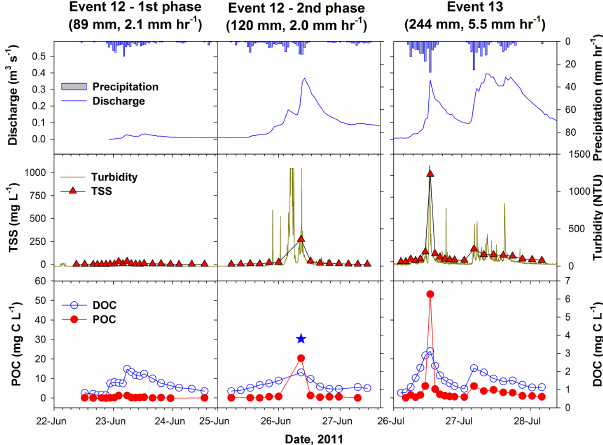
Figure 3. Temporal variations in hourly precipitation (mmh − 1 ) , discharge (m 3 s − 1 ) , turbidity (NTU), and the concentrations (mgL − 1 ) of TSS, DOC, and POC in the forest stream during two extreme storm events in 2011. Concentrations of TSS, DOC, and POC were measured for water samples collected at 2-hour inter- vals. The star symbol above the peak concentrations of DOC and POC on 26 June indicates grab sampling conducted for the labora- tory BDOC incubation